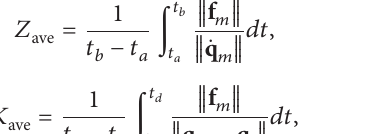
= 130 ,and 𝐵 = 250 andtime-varying max ave = [10, 250] tv